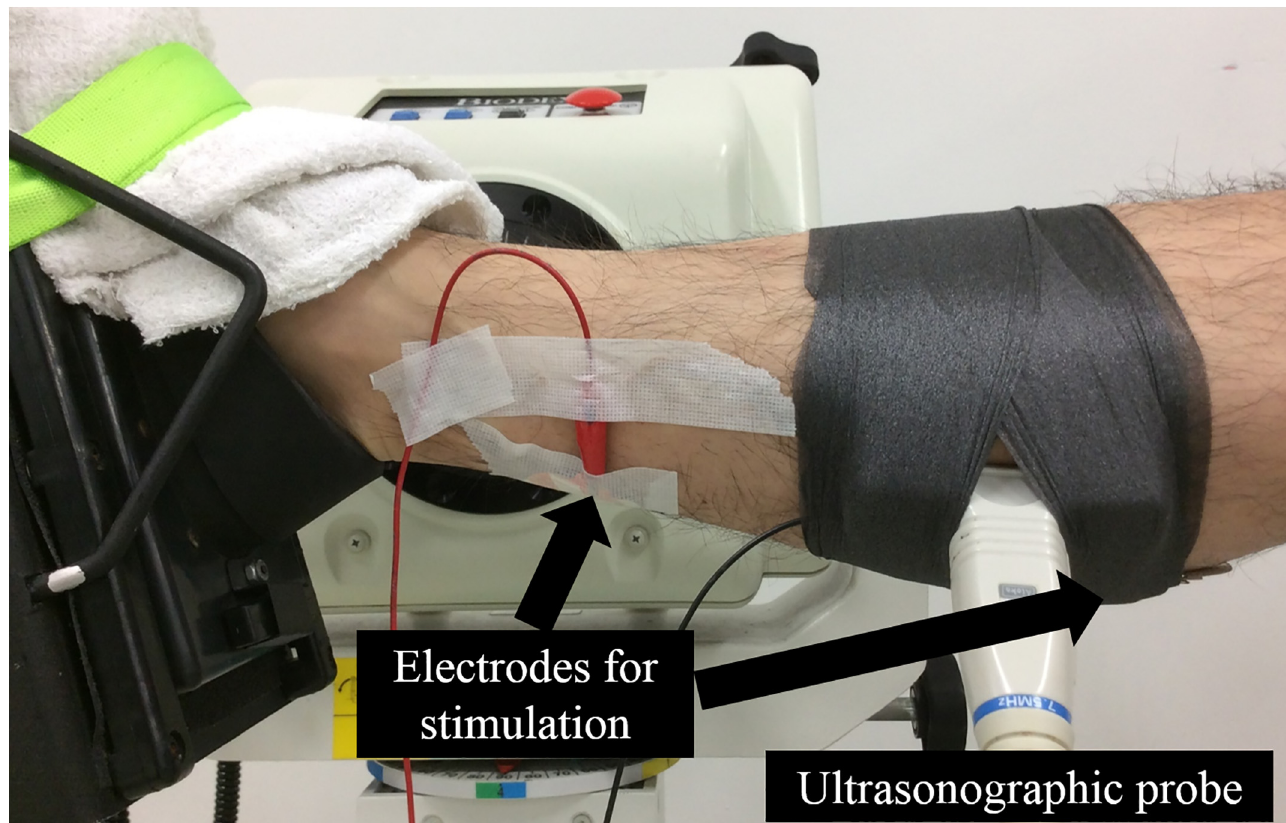
Fig 1. Experimental